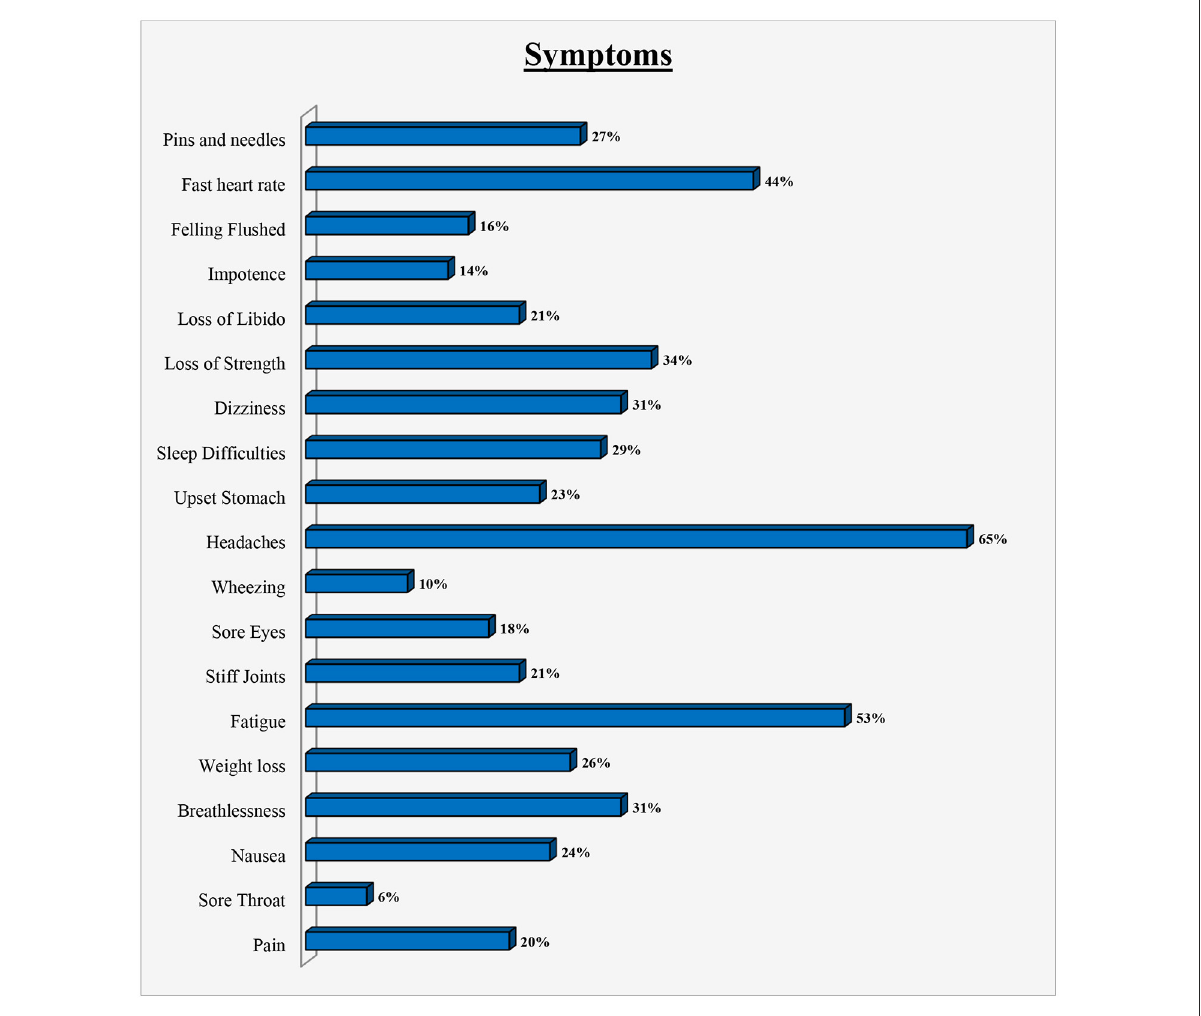
FIGURE1 Symptoms experienced by